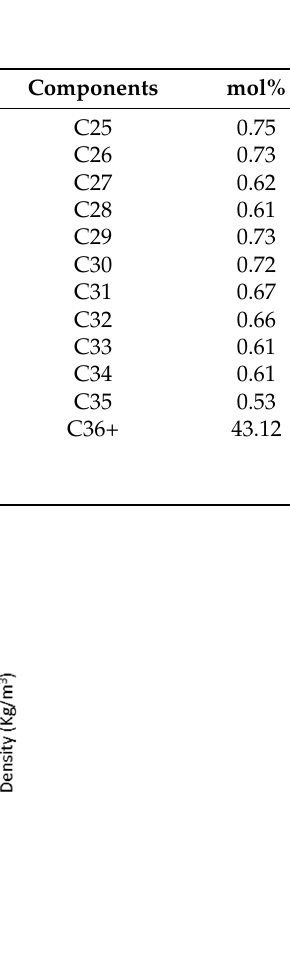
Figure 4. Oil viscosity and oil density with different CO 2 concentrations. Table 2. Viscosities and densities of the heavy oil–CO 2 system with different CO 2